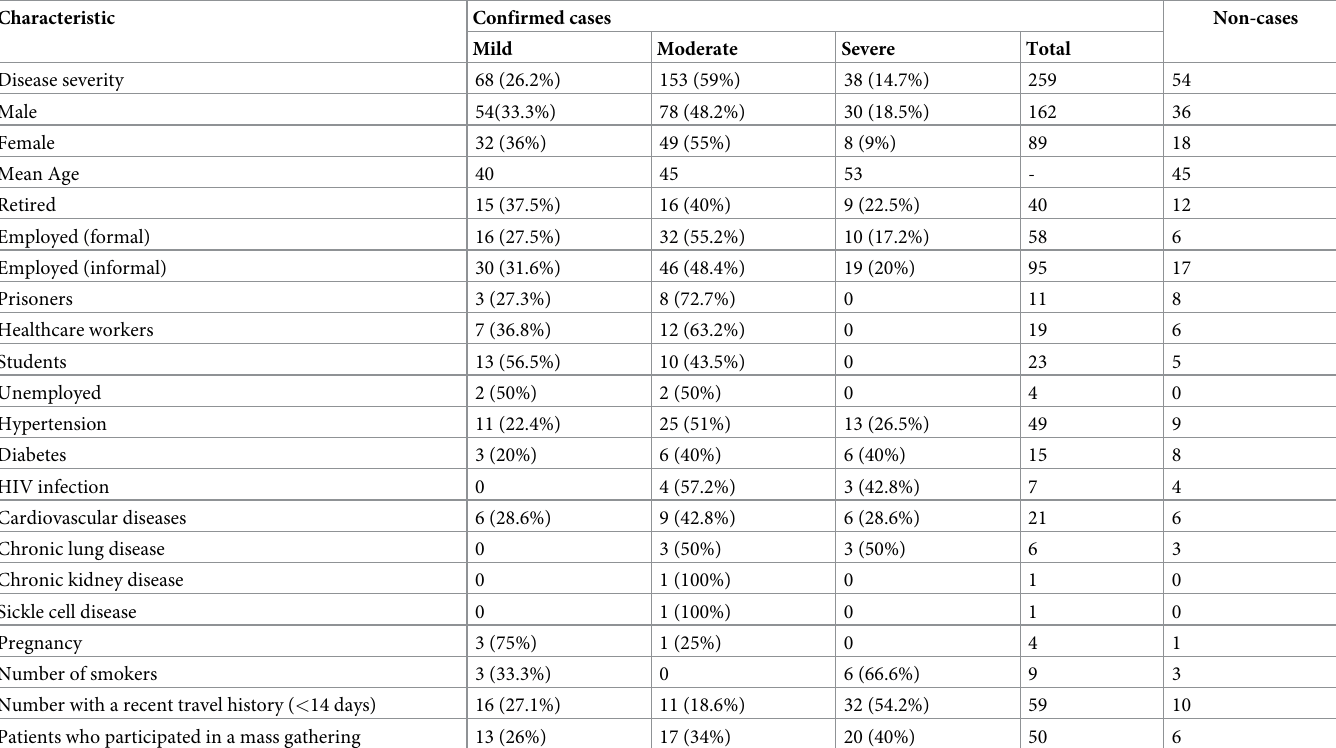
Table 1. Clinical characteristics of patients admitted for suspicion of COVID-19 at the Djoungolo Hospital.